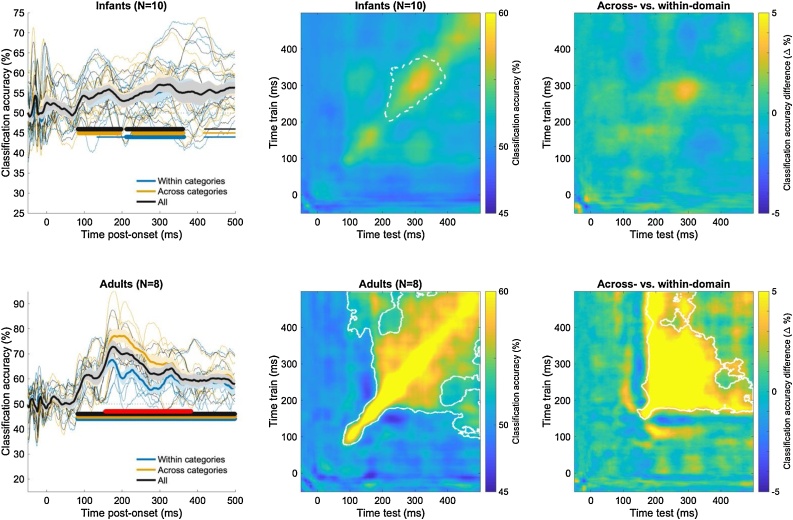
Average accuracy for the pairwise classification of visual stimuli in infants (12-15-month-olds) and adults. Left: Average ± s.e.m. accuracy timeseries for pairwise, within-subject classification within (e.g. cat vs. dog) or across domains (e.g. cat vs. hand). Thick (resp. thin) horizontal lines indicate statistically significant (resp. marginally significant) clusters of the difference between accuracy and the chance level of 50 % (one-tailed). Red horizontal lines indicate significant clusters for the difference in accuracy between classifications across vs. within domains (one-tailed). Middle: Average, within-subject time generalization accuracy for all pairwise classifications. Solid (resp. dotted) white lines indicate the border of statistically (resp. marginally) significant 2-D clusters of the difference between accuracy and the chance level of 50 %. Right: Average difference of within-subject time generalization accuracy for pairwise classifications across (e.g. cat vs. hand) vs. within (e.g. cat vs. dog) domains (e.g. cat vs. dog). White lines indicate the border of statistically significant clusters of this difference. See also Supplementary Fig. 2.